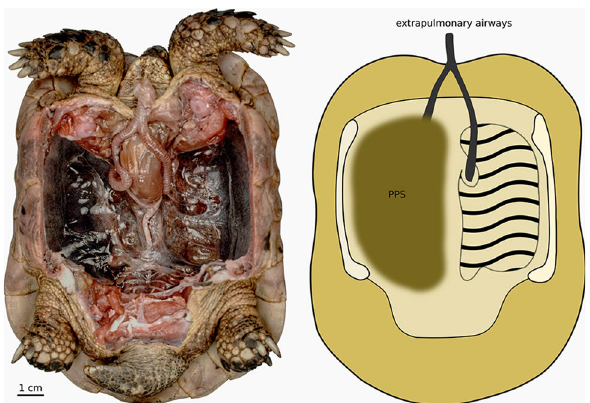
Figure 2. The Post Pulmonary Septum in Testudo Overview of the coelomic subdivision and the resulting compartmentalization of the respiratory system in tortoises. The left image shows in a ventral view the viscera, except for the lungs, have been removed. The schematic drawing on the right indicates the structures in question. Unlike in most other clades of chelonians, the ventral side of the lungs is completely covered by the postpulmonary septum (PPS). The anatomically left side shows the medial parts of the PPS removed, giving a clear view on the actual lungs beneath (i.e. dorsal to) it. Dorsally, the lungs are broadly fused to the inner side of the carapace (indicated by the wavy lines), resulting in a firm fixation within the pleural cavity. Note the PPS extending laterad to the carapace. The anatomical configuration serves as a mechanical support system in inverted tortoises whose viscera are pushing on the lungs. As a consequence, the PPS prevents gravitational pulmonary collapse in inverted specimens and hence counteracts the resulting decrease in compliance together with the associated increase in work of breathing. Photograph taken by